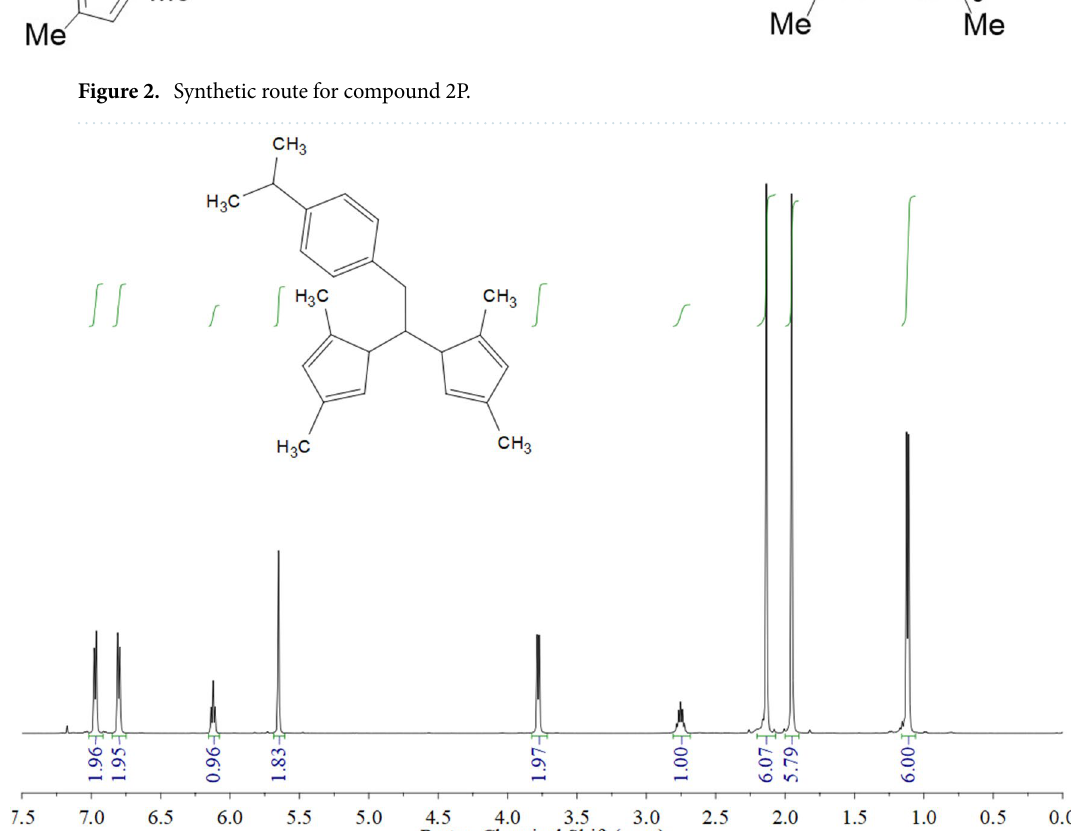
Figure 3. 1 H-NMR spectrum for the 2P compound in CDCl 3 at 297